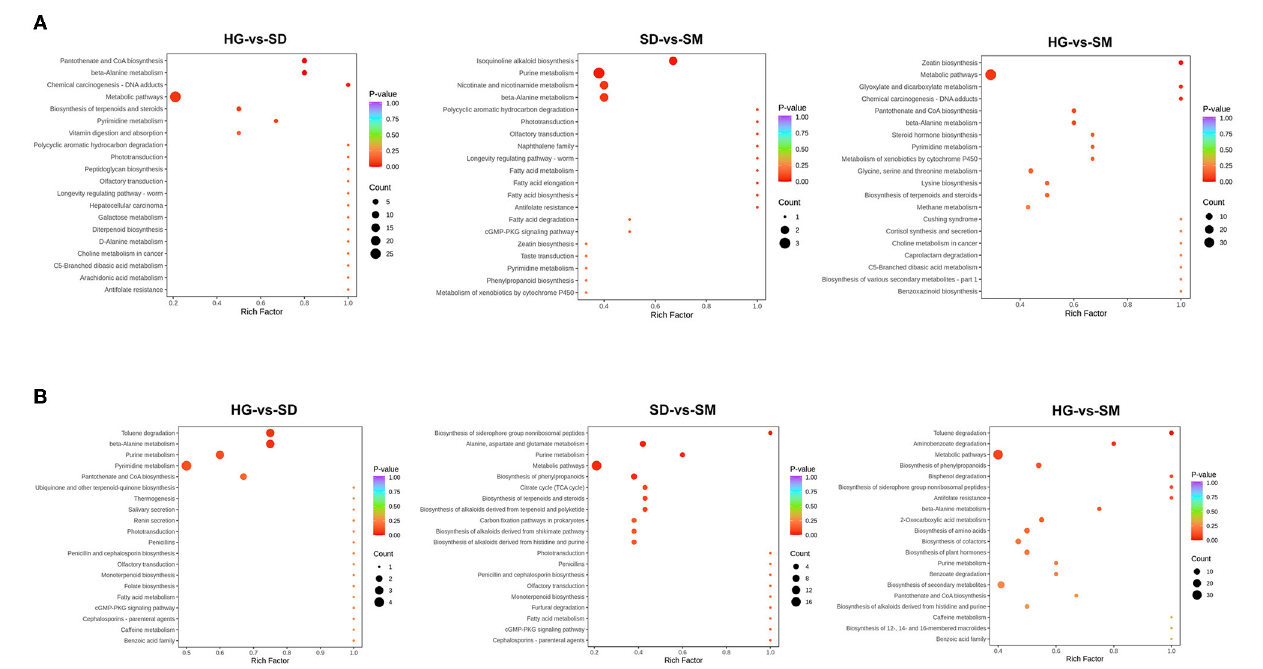
FIGURE5 KEGG annotation of DAMs in the three compared groups at the positive and negative ion modes. (A) The KEGG annotation of DAMs detected at positive ion modes. (B) The KEGG annotation of DAMs detected at negative ion